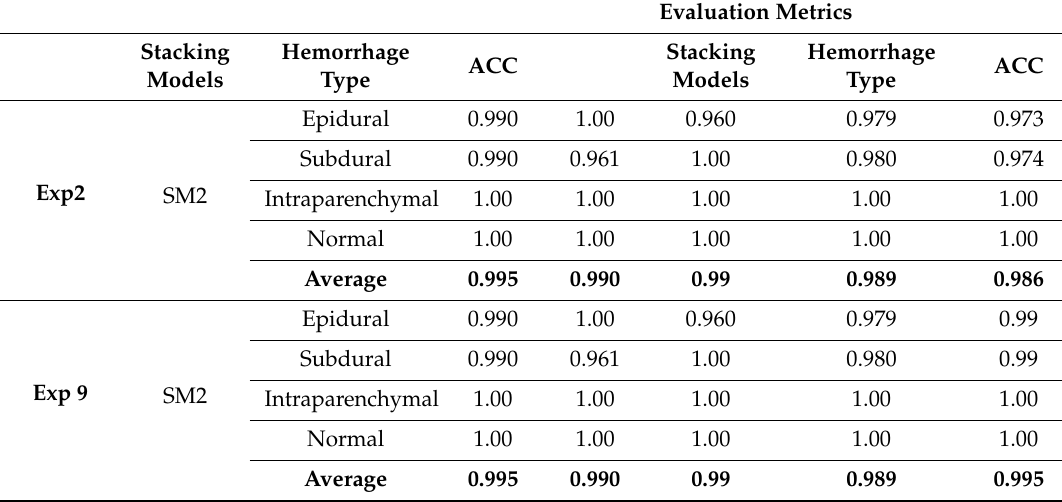
Table A4. Class-wise and average values of performance metrics of stacking models on CT scan dataset for two di ff erent experiments, Exp2 and Exp